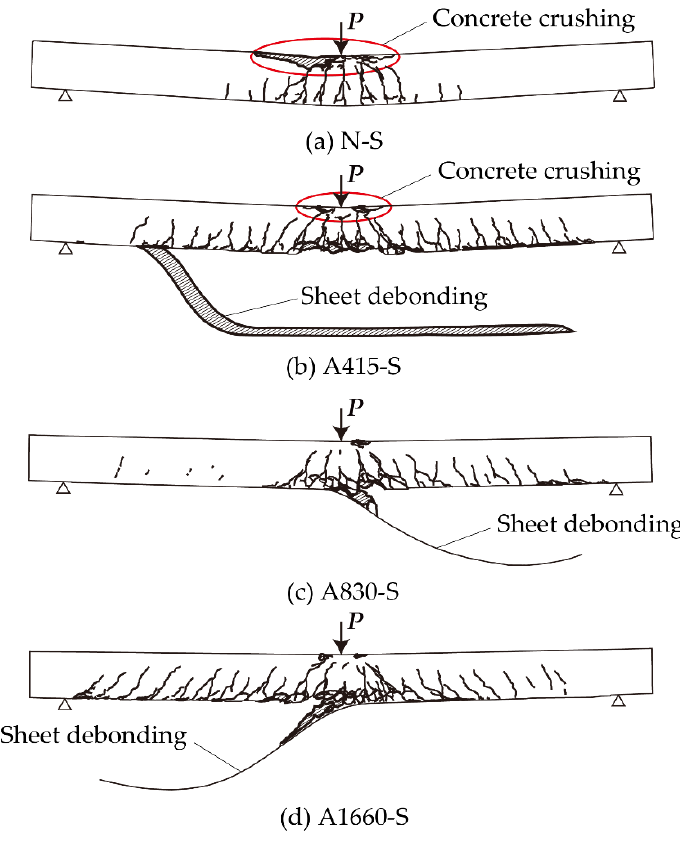
Figure 10. Crack distribution of the beams after static loading tests.